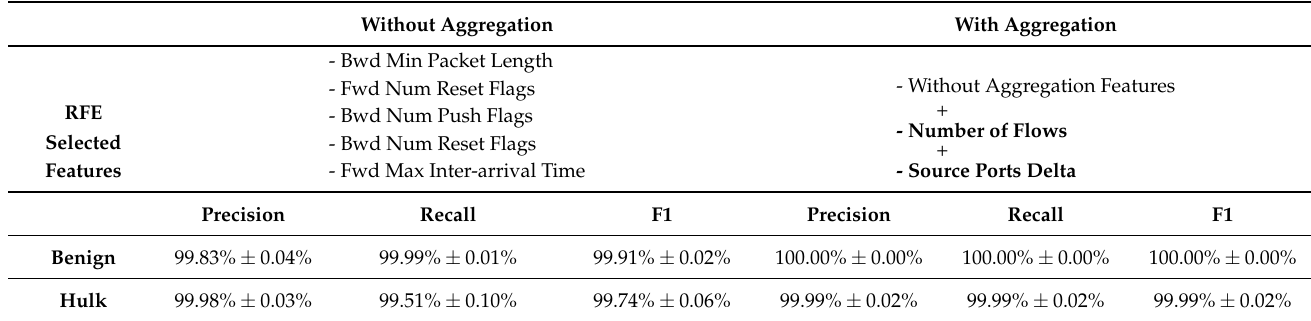
Table 6. Benign vs. DoS Hulk classification (5-fold cross validation).